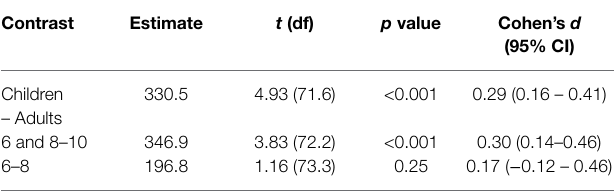
TABLE 5 | Contrasts among age groups on RTs in Experiment 1. Contrast Estimate p